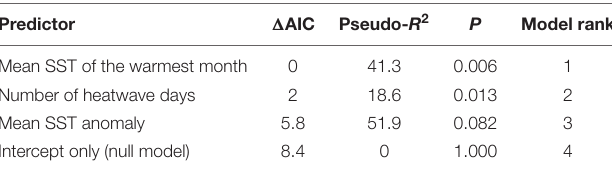
TABLE 1 | Summary of model comparisons examining the relationship between giant kelp resistance and the three SST metrics from July 2014 to June 2016.